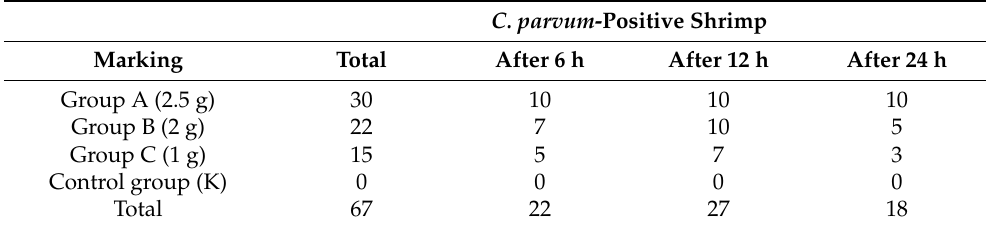
Table 2. Overview of C. parvum- positive Neocaridina shrimp after filtration of oocysts from water.